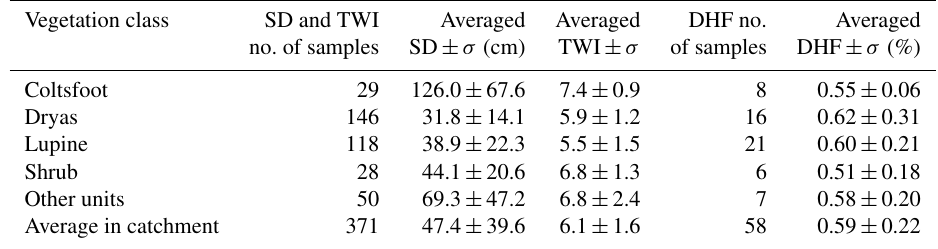
Table 3. Averaged SD and DHF for each of the vegetation classes. Vegetation class SD and TWI Averaged Averaged DHF no. Averaged